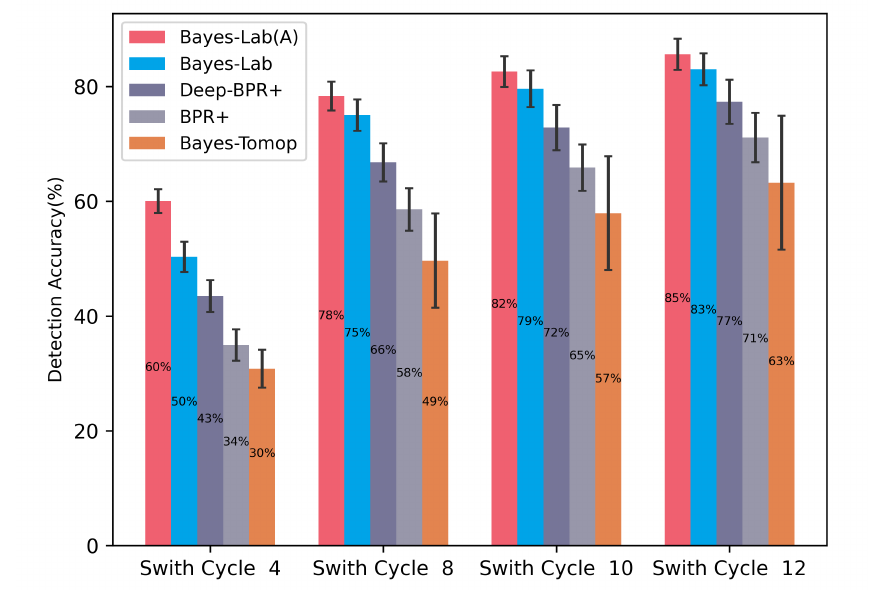
Figure 11. The effect of the switching interval on the detection